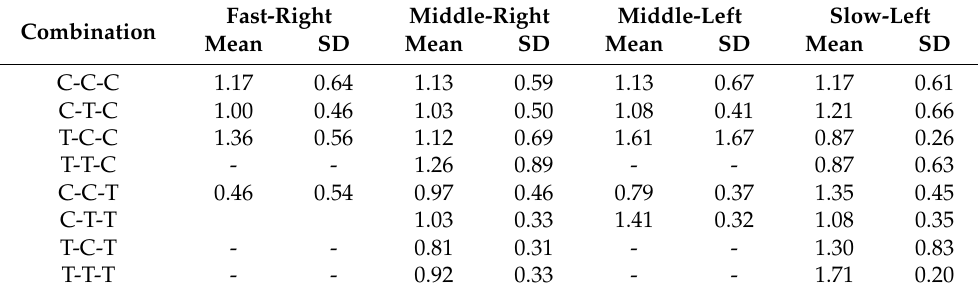
Table 5. The mean and standard deviation of T a of